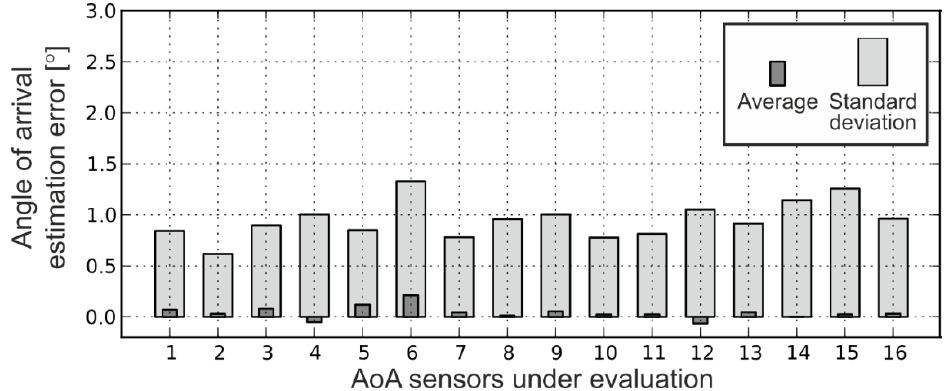
Figure 6. Angle of arrival estimation error for 16 different sensors.